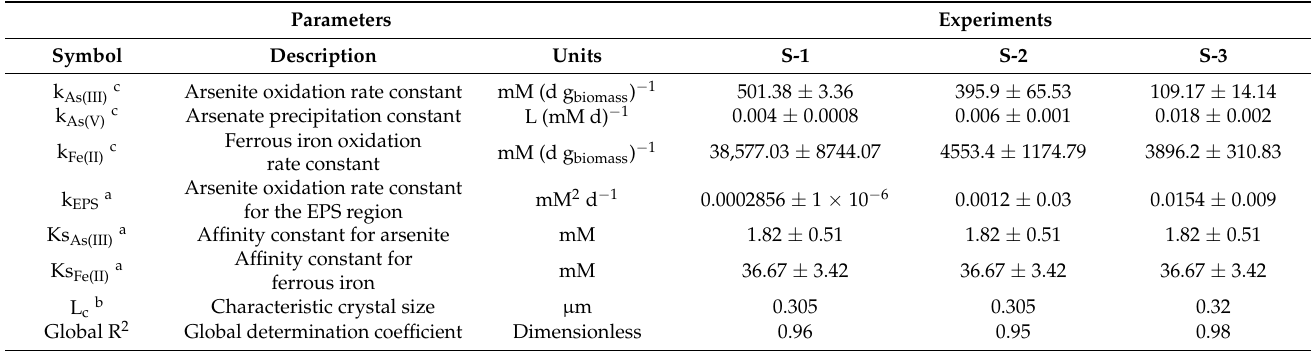
Table 3. Parameter values and their confidence intervals (95%) for the experiments from Table